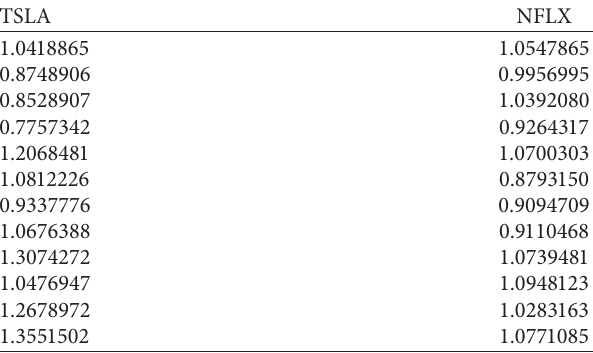
Table 1: Dataset from